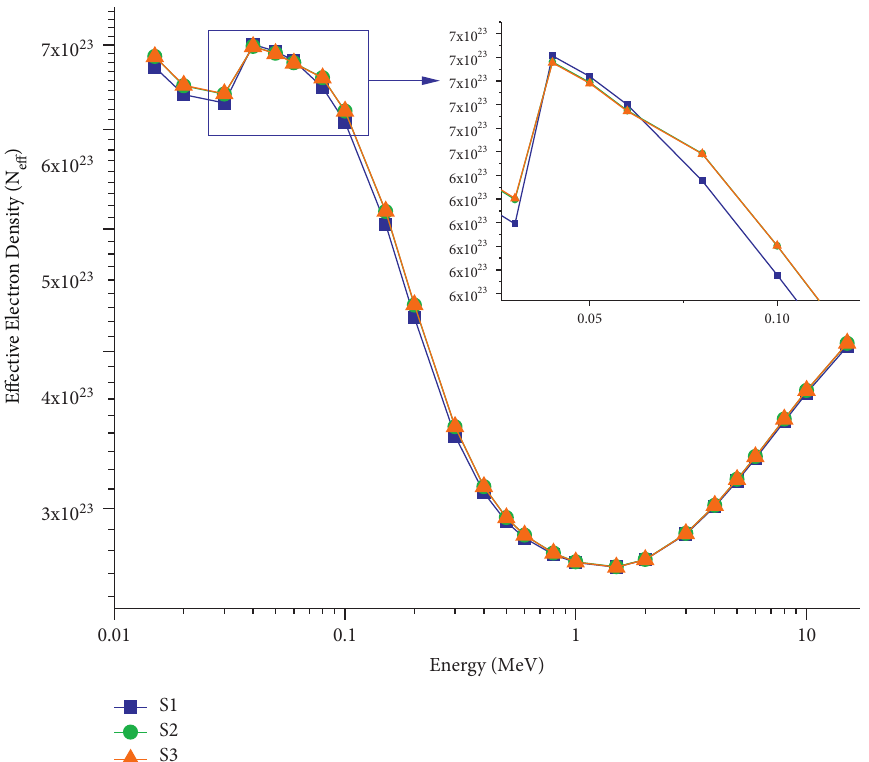
Figure 9: Variations of the effective electron density (N